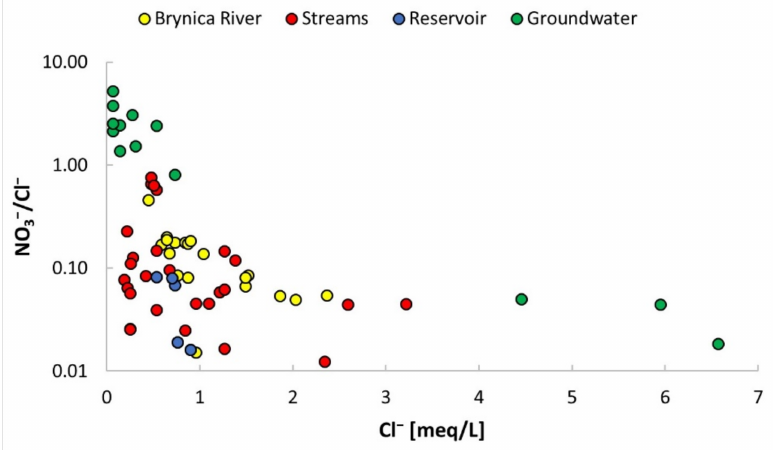
Figure 6. Relationship between NO 3 − /Cl − ratio and concentrations of Cl −